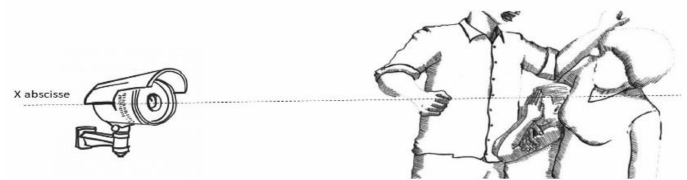
Figure 1. The body of the aggressor prevents the ability to see the entire body of the